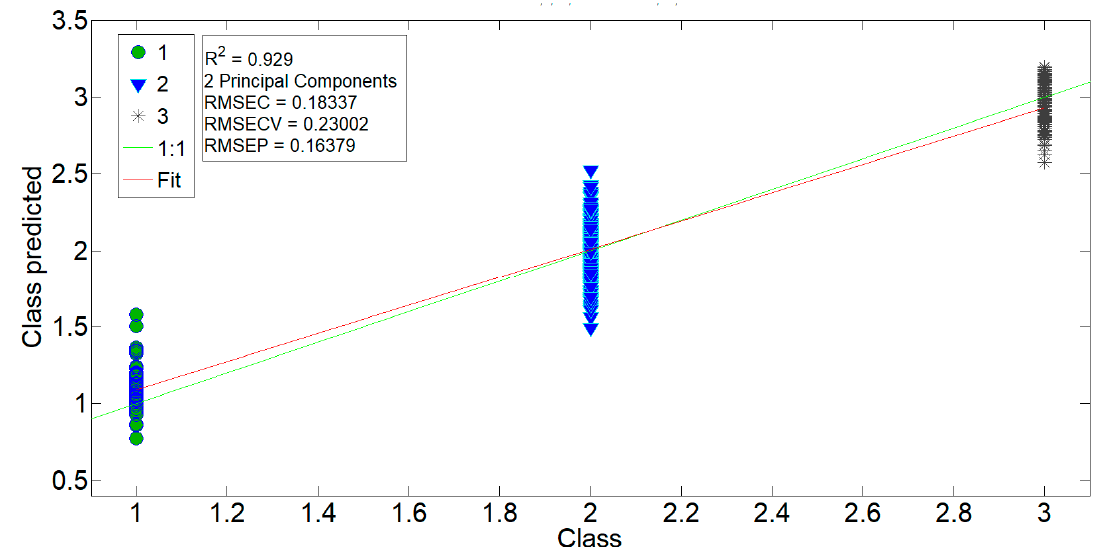
Figure 5. Results for the regression model PCR2 calculated for the 1800–935 cm − 1 region. Data were trained against their respective class on the 3-, 5-, 10-, and 40-min spectra and then validated by the 15-, 20-, and 25-min spectra. For details, see Table 2.